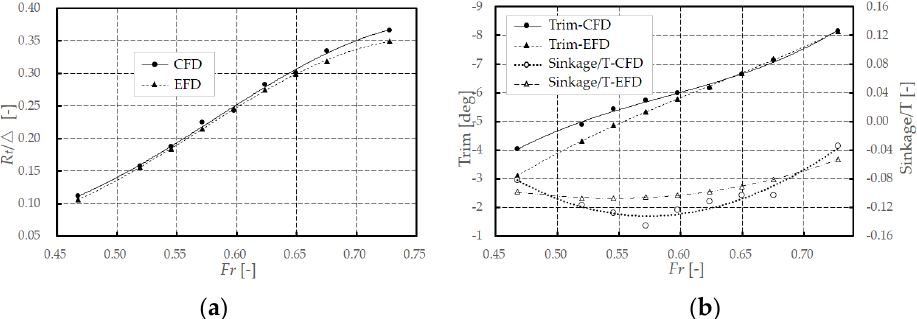
Figure 7. The numerical simulation results and the test results of the bare vehicle model. ( a ) Resistance of the bare vehicle model; ( b ) Attitude of the bare vehicle model.